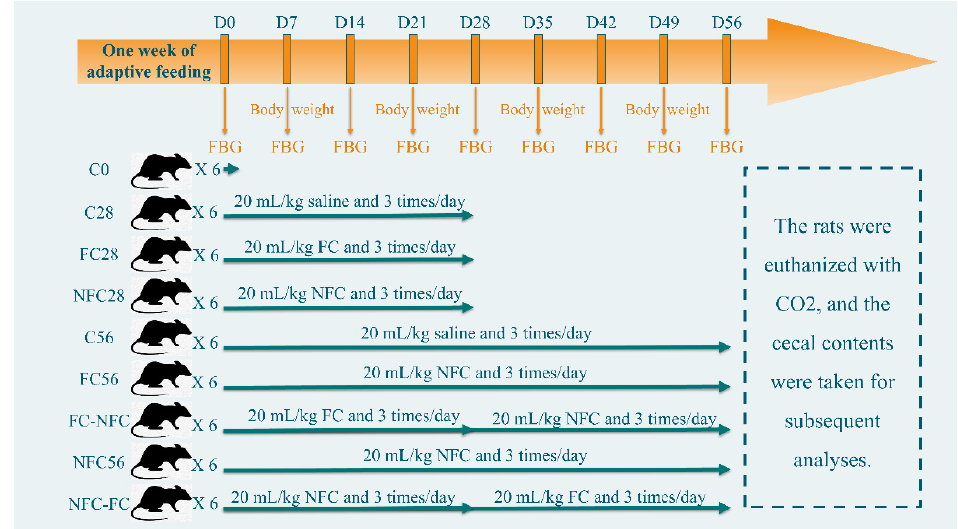
Figure 1. Schematic diagram of animal experimental scheme.